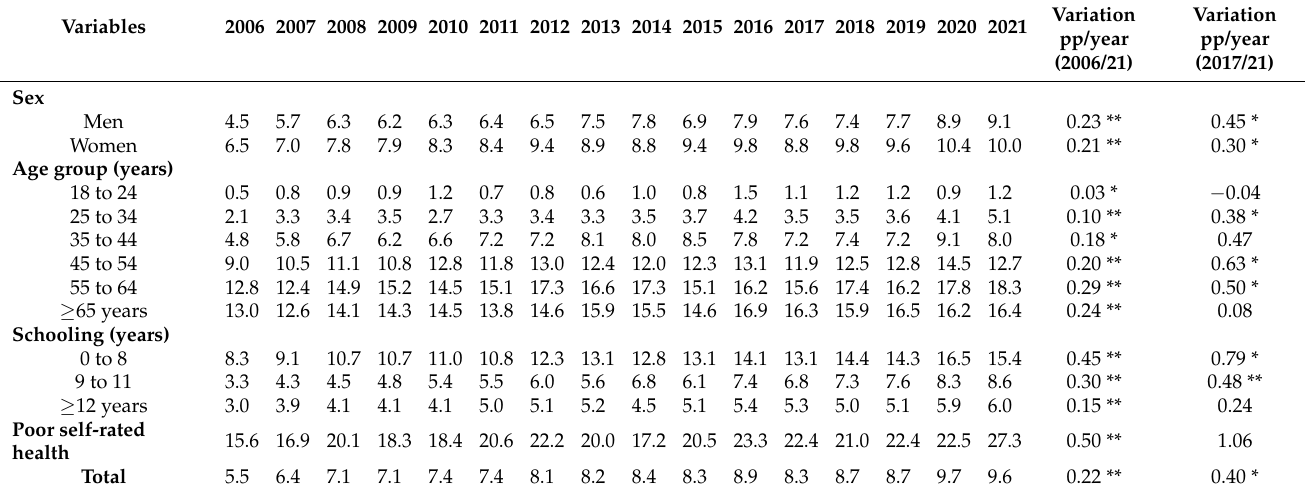
Table 4. Prevalence (%) of co-occurrence of obesity and diabetes and/or hypertension among Brazilian adults ( ≥ 18 years), by year, according to sociodemographic characteristics and self-rated health. Vigitel Brazil,